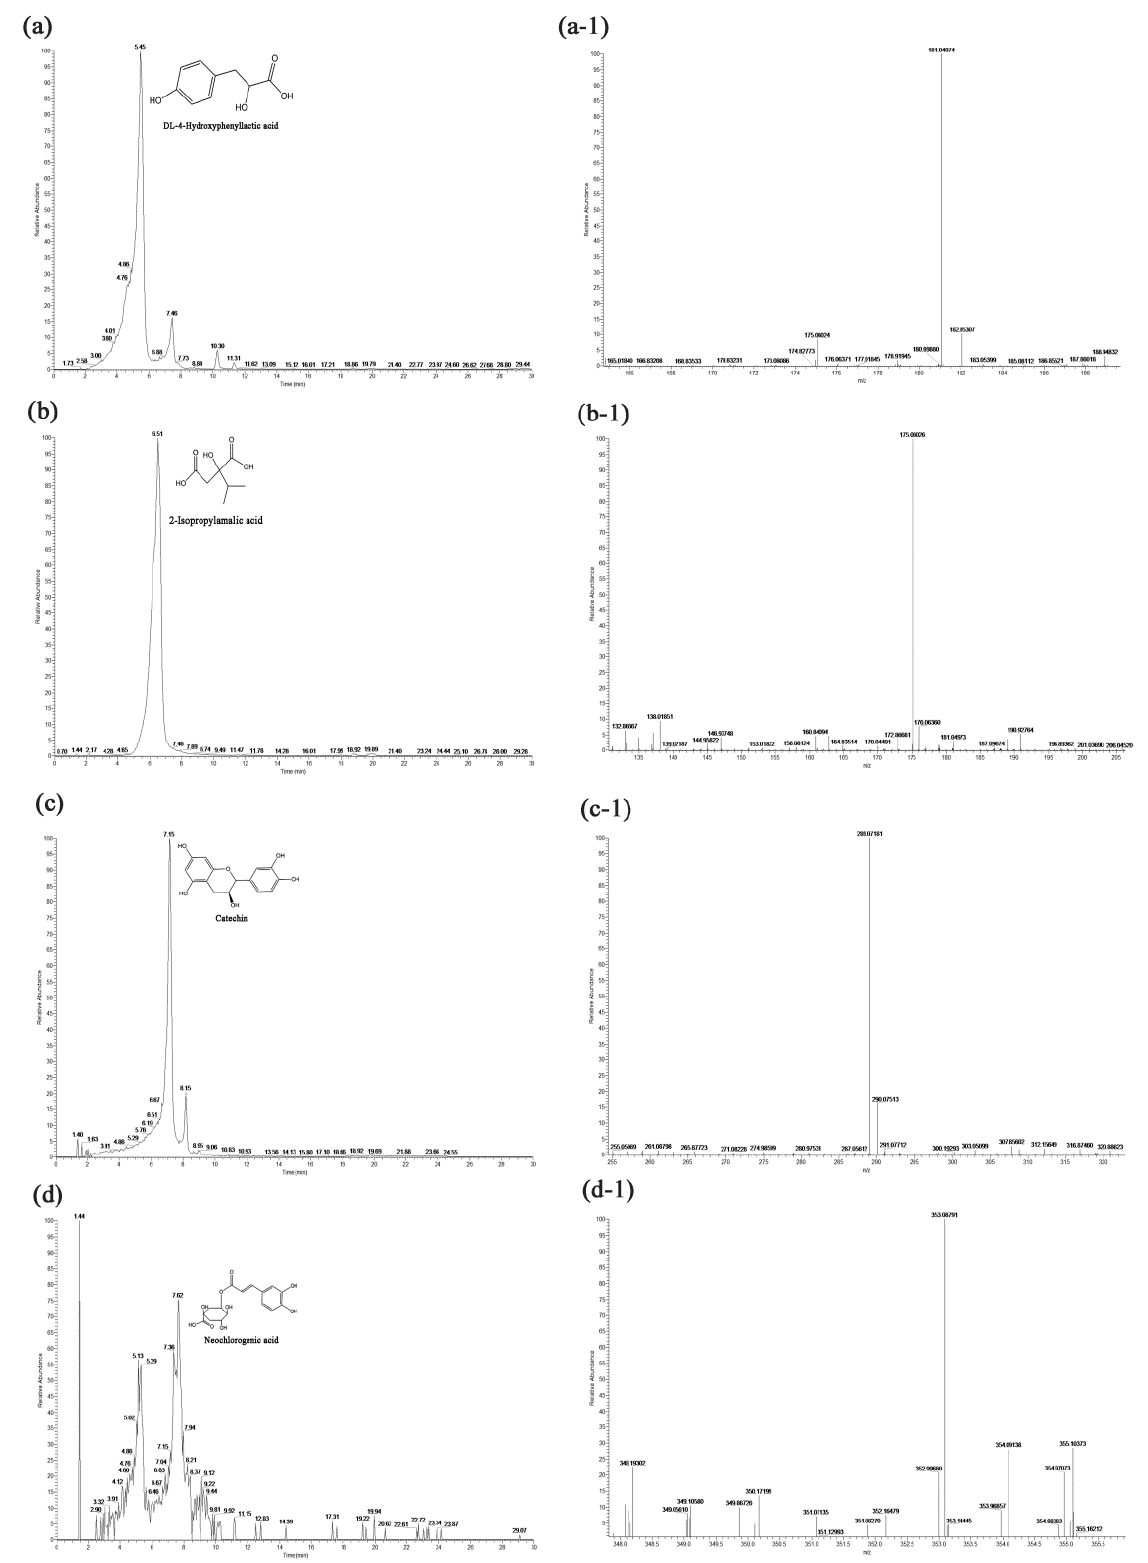
Figure 7. Identification of 21 kinds of compounds from HBVN by UHPLC–PAD–MS/MS. ( a ) UPLC chromatogram of DL-4-hydroxyphenyllactic acid, ( a-1 ) MS for DL-4-hydroxyphenyllactic acid, ( b ) UPLC chromatogram of 2-isopropylmalic acid, ( b-1 ) MS for 2-isopropylmalic acid, ( c ) UPLC chromatogram of catechin, ( c-1 ) MS for catechin, ( d ) UPLC chromatogram of neochlorogenic acid, ( d-1 ) MS for neochlorogenic